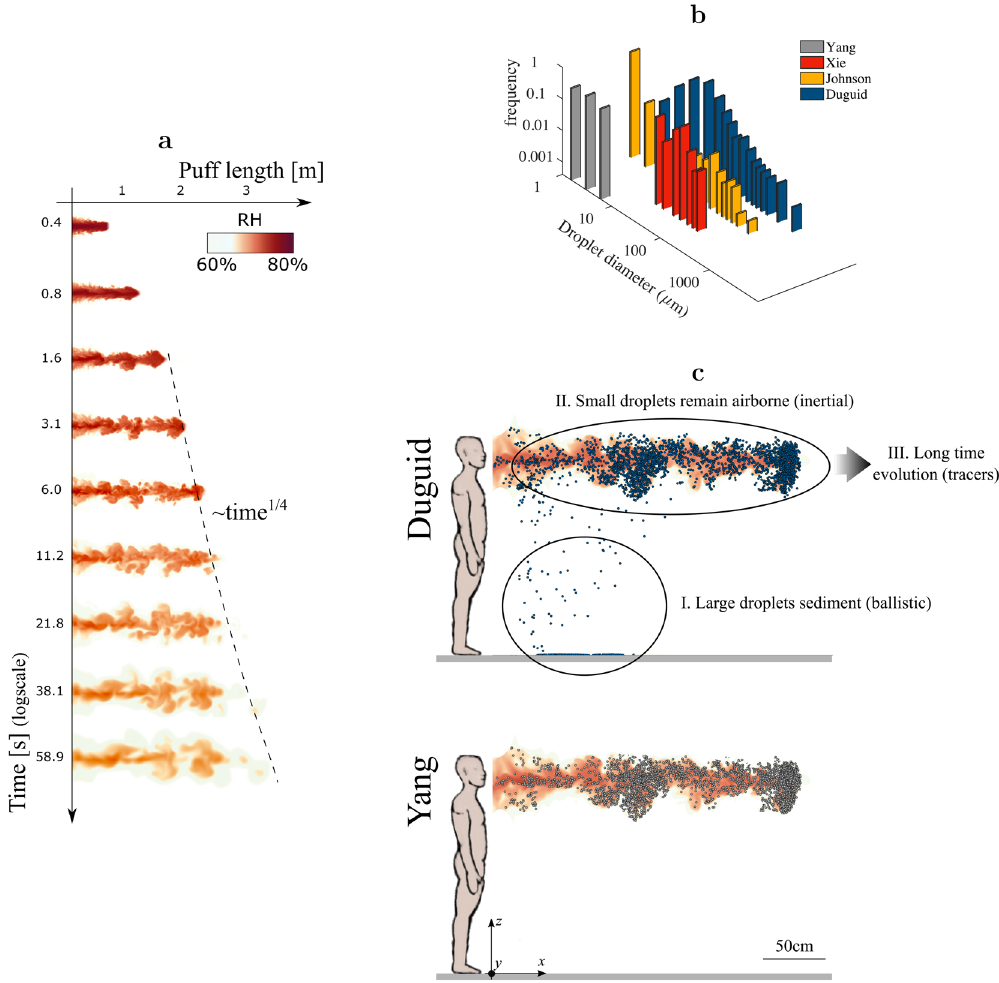
Figure 1. Airflow generated during coughing. ( a ) Evolution of the relative humidity in space and time. After 1 / 4 the end of the exhalation, the emitted air behaves as a turbulent puff growing in length as ∼ t and decaying − 3 / 4 in amplitude as ∼ t (the latter is shown in Fig Supplementary 1). ( b ) Droplet initial size distributions considered in the present study: Duguid 11 (blue), Johnson et al. 16 (yellow), Xie et al. 14 (red), Yang et al. 15 (gray). ( c ) Relative humidity (color coded) and exhaled droplets (blue and gray spheres, not in scale) after 7.6s considering two different initial droplet size distributions: (top) Duguid 11 ; (bottom) Yang et al. 15 showcases the dramatic differences in predictions depending on the initial distribution of droplet sizes. The distribution of droplet sizes from Duguid 11 contains large droplets that rapidly settle carrying most viral load on the ground, as well as many small droplets which remain airborne. In contrast, in the size distribution from Yang et al. 15 all droplets are small enough to remain airborne for the entire simulation. The ambient RH is 60% in all figures. Scale bar: 50